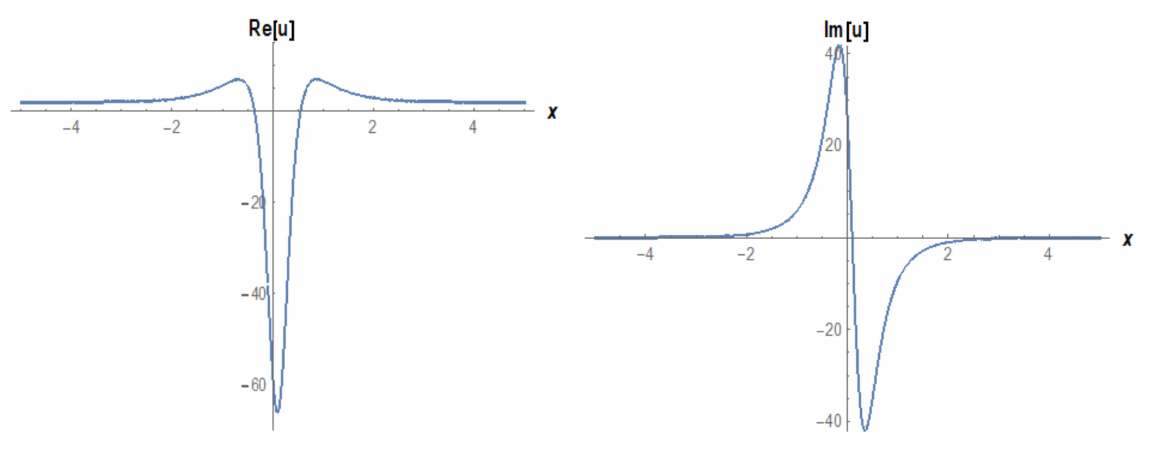
Figure 16. The 2D graphs of Equation (26) under the values of ε = 0.4, t = 0.5, − 5 < x <